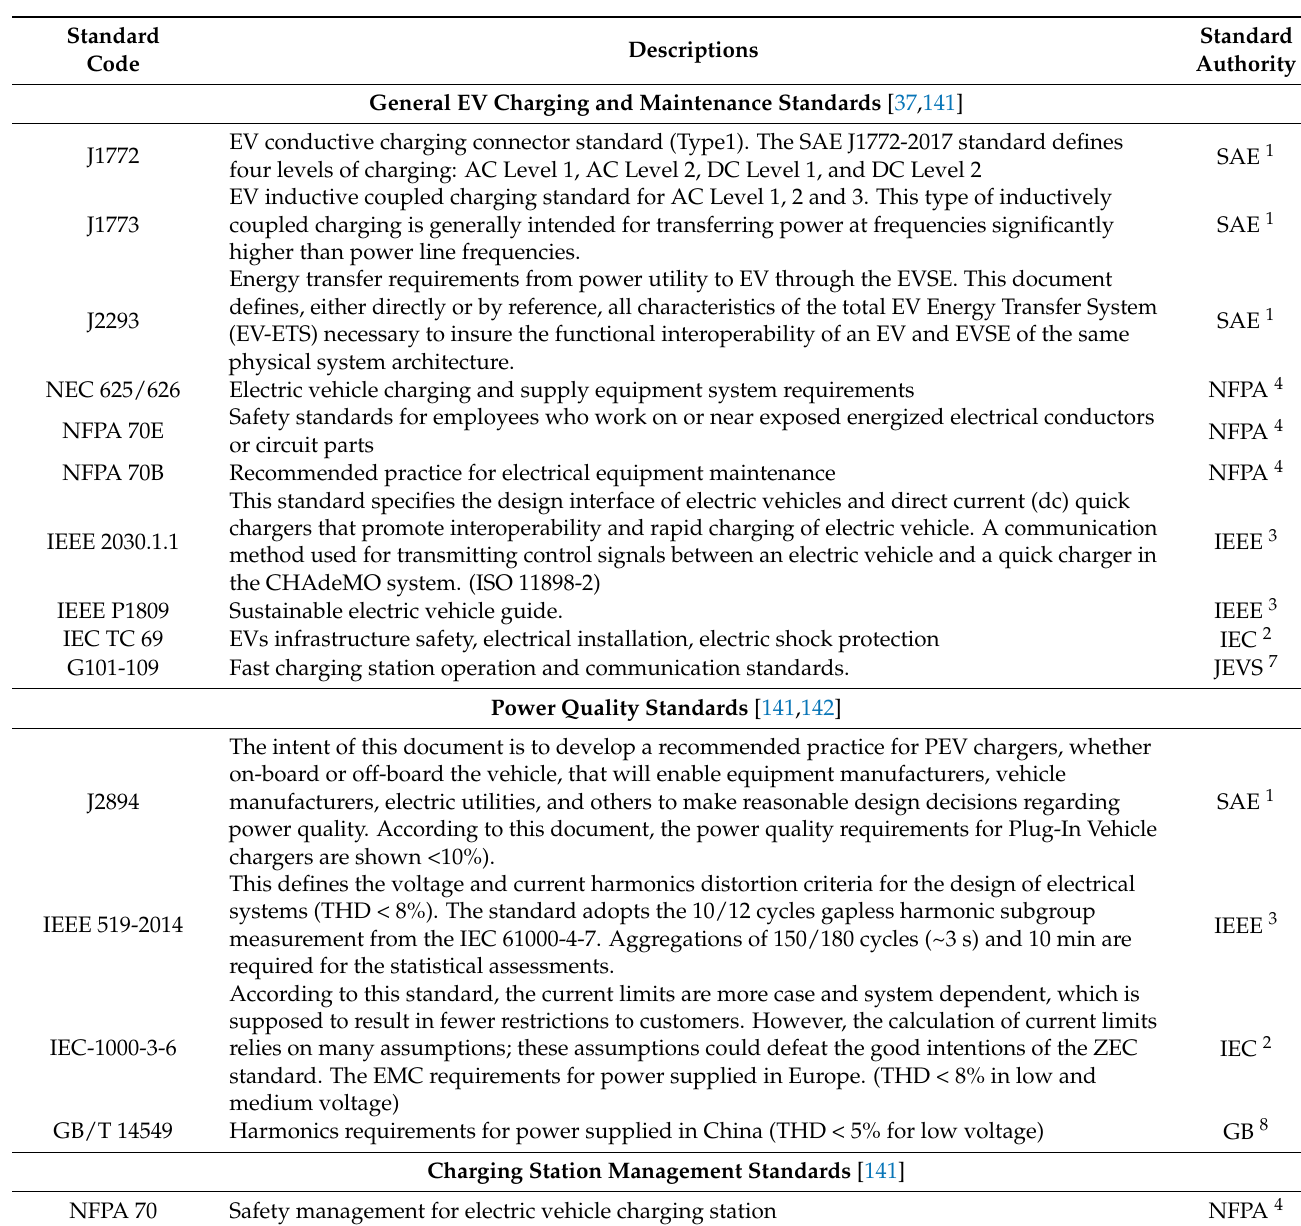
Table 8. International standards for electric vehicle charging